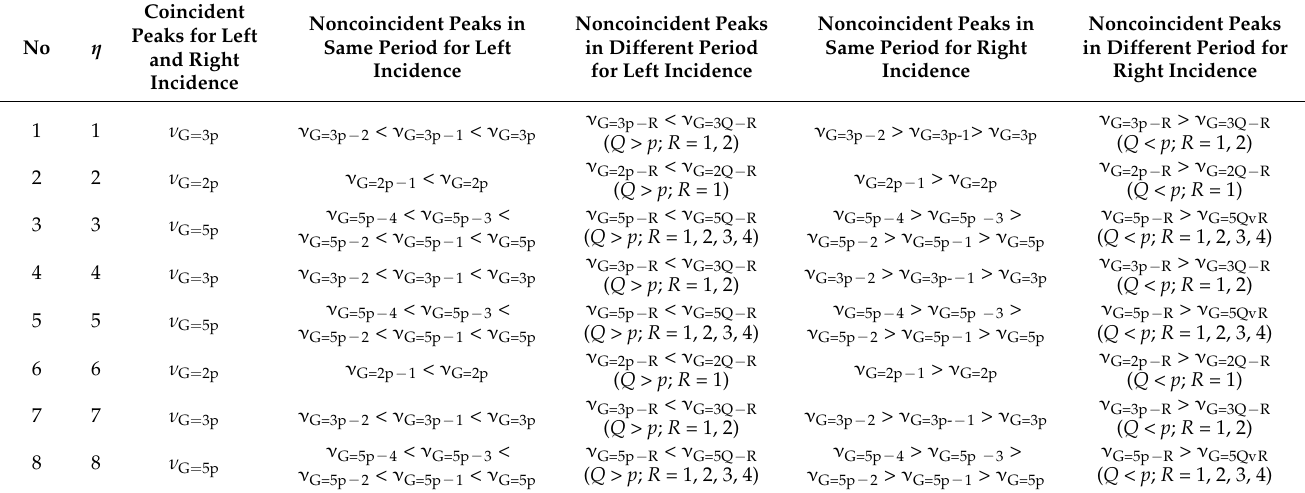
Table 2. For a given value of η , the frequency position rules of the left (right) transmission (reflection) peaks with the increment of G , where p ( p = 1, 2, . . . ), Q , and R in the table are positive integers. Noncoincident Peaks in Noncoincident Peaks Noncoincident Peaks in Noncoincident Peaks Same Period for Left in Different Period Same Period for Right in Different Period for Incidence for Left Incidence Incidence Right